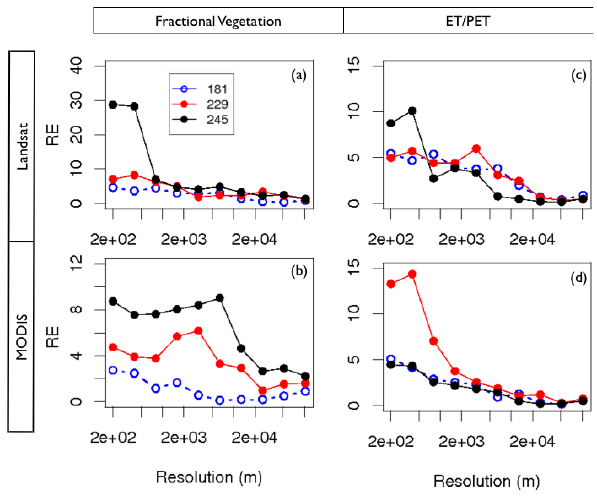
Fig. 7. Relative entropy between each scale of controlling variables (left) Fc and (right) ET / PET to the modeled ET flux from each sensor for each day for (top) Landsat and (bottom)